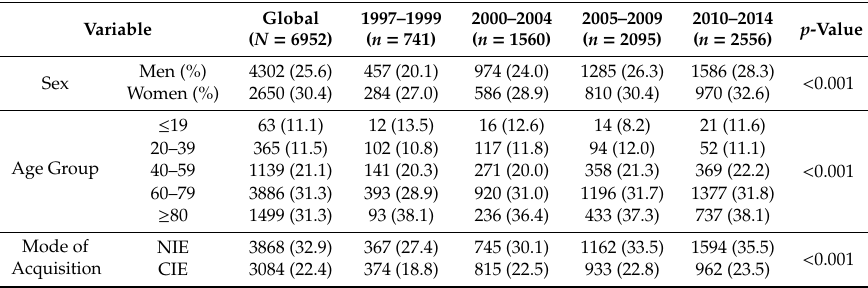
Table 3. Overall and trends of mortality in Spain from 1997 to 2014 classified by gender, age group, and mode of acquisition of infective